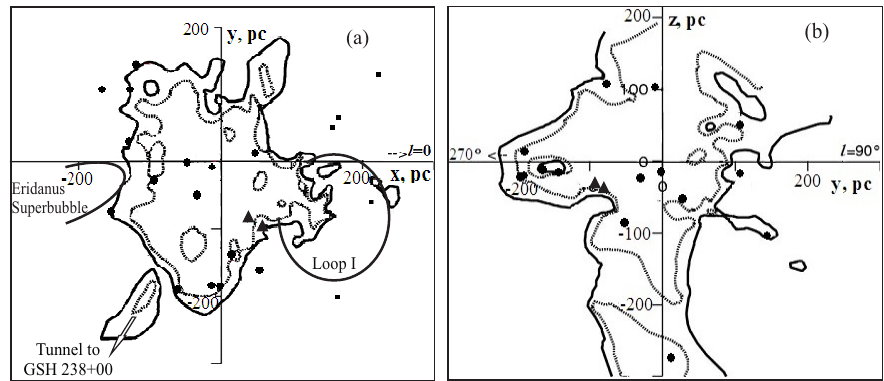
Fig. 1. The Local Bubble according to Lallement et al. (2003), projected on the galactic (a) and rotation (b) planes. The curves are Na I equivalent width contours for 20 m(cid:23)A and 50 m(cid:23)A, which are associated with the Local Bubble boundary. The positions of Loop I, the Eridanus Superbubble, and the direction of the GSH 238+00+09 supershell are shown in panel (a). The Sun is at the origin of the coordinates. The circles denote the open clusters associated with the Local Bubble; the squares mark other clusters in the selected area. The positions of the young clusters Feigelson 1 and Mamajek 1 are shown as triangles (see text for